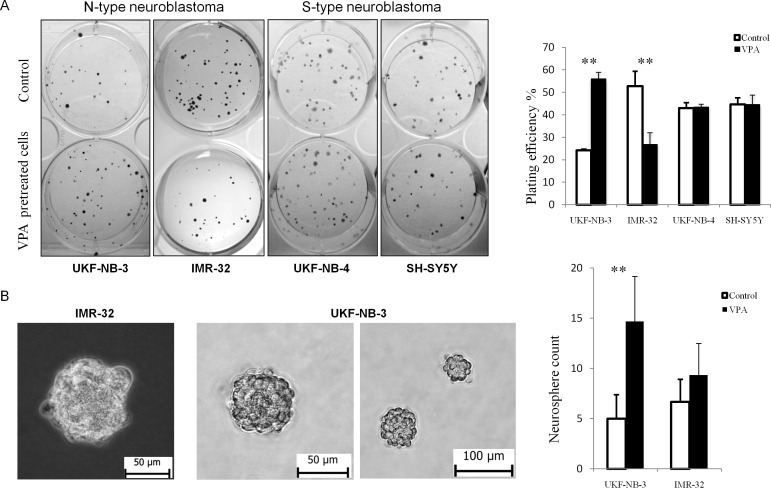
Effect of 1mM VPA on clonogenicity and neurosphere formation in NB cell lines.(A) Pretreatment with VPA significantly increased the clonogenicity in UKF-NB-3, while it decreased in IMR-32. In S-type NB (UKF-NB-4, SH-SY5Y) clonogenicity was not affected by pretreatment with VPA. VPA- cells pretreated with 1mM VPA for 72 hrs. (B) Both UKF-NB-3 and IMR-32 were able to form neurospheres in SFM. Pretreatment with 1mM VPA increased the number of formed neurospheres with high statistical significance in UKF-NB-3.